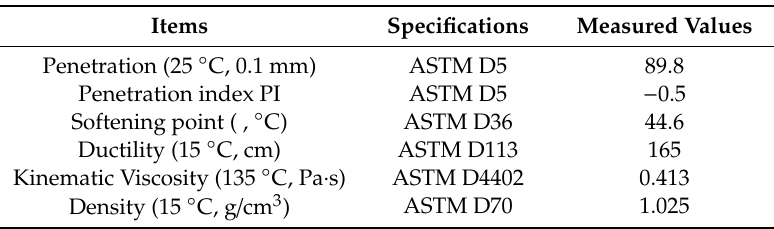
Table 1. Basic information of the base